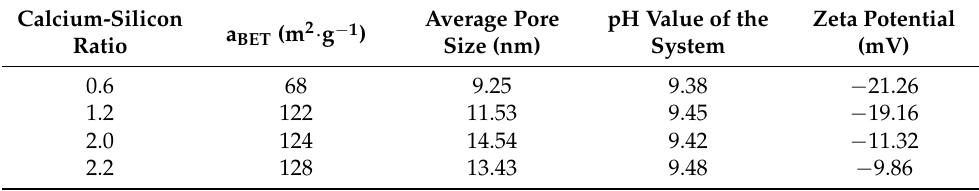
Table 1. Specific surface area(a BET ) and zeta potential of CSH gel with different calcium silicon ratio.